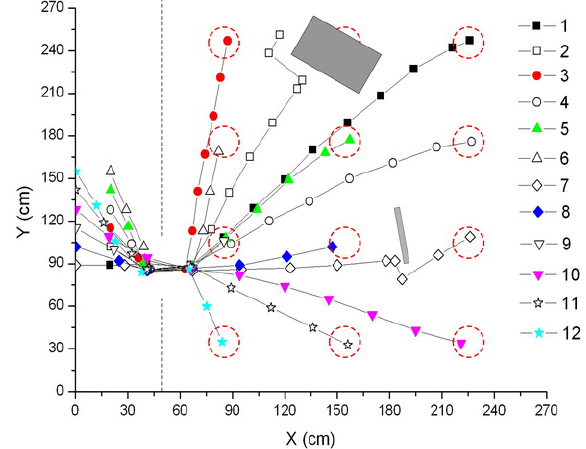
Figure 18. Coverage routes of the mobile nodes during the deployment process.